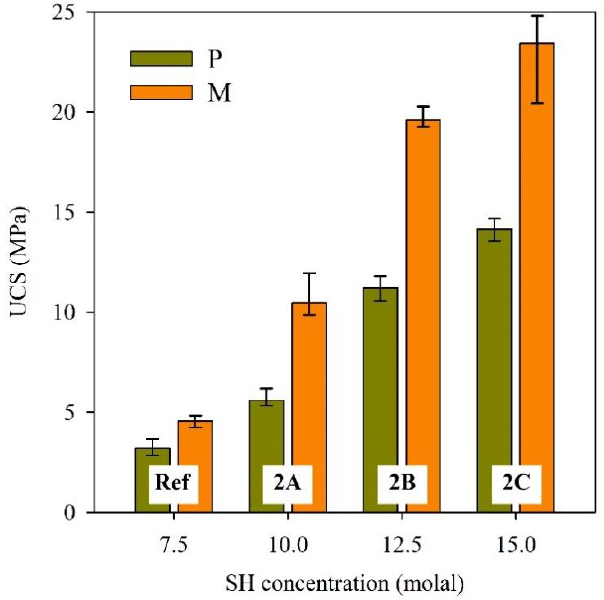
Figure 5. Influence of the sodium hydroxide concentration on compressive strength.